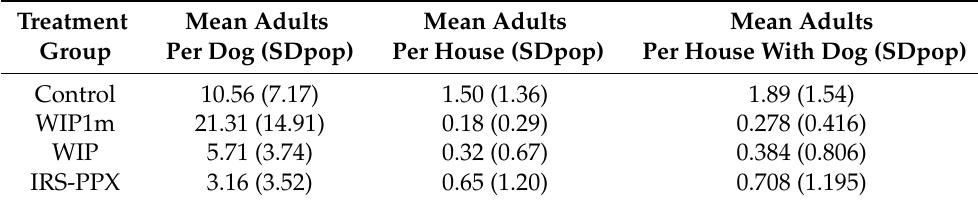
Table 2. Average adults found per dog, per house, and per house with dogs, days 1–9. Treatment